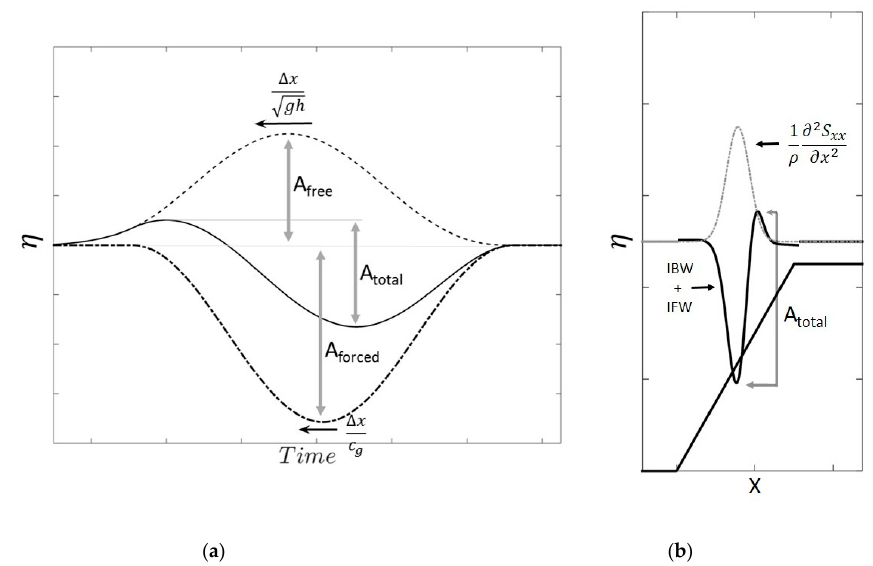
Figure 3. ( a ) Schematic representation of the surface elevation at a fixed position for a superposition of forced and free waves. Dot-dashed line - bound wave propagating with group velocity and amplitude A forced . Dashed line - free wave generated during the shoaling process propagating with with respective amplitude A + . Full line - total signal with amplitude A total . ( b ) Spatial representation of bound wave shoaling. Black line, superposition of incident bound wave (IBW) and an incident forward free wave (IFW) generated to balance changes in the forced solution during shoaling. Dotted-dashed line is the representation of the radiation stress forcing.